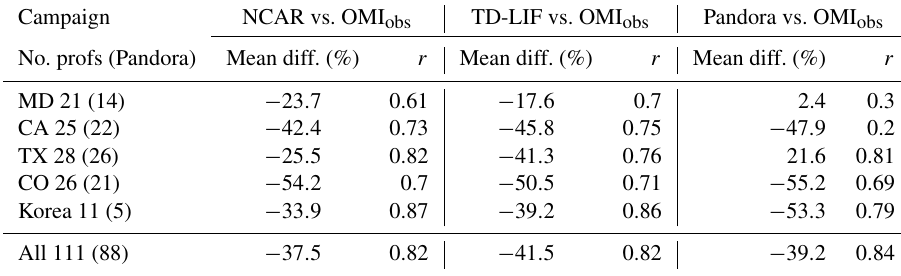
Table A3. Same as A2, but for OMI using AMF obs (OMI obs ). Campaign